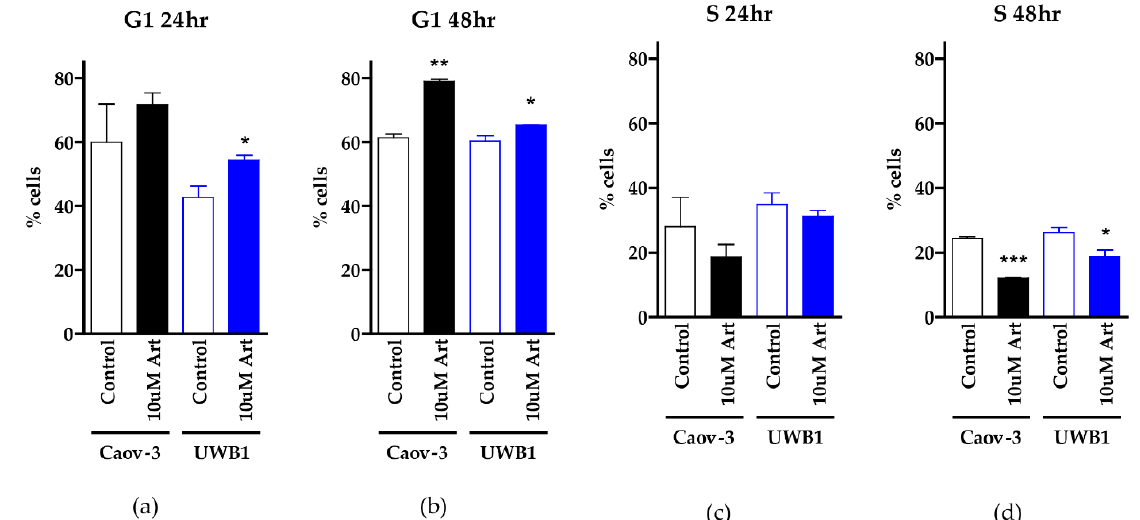
Figure 4. Cell cycle analysis using propidium iodide staining. The percentage of Caov-3 and UWB1 cells in G1 after 24 h ( a ) or 48 h ( b ) treatment with 0.1% DMSO (control) or 10 μM artesunate is graphed as the mean +/− SD from three independent experiments. A one-tailed unpaired t-test revealed a statistically significant increase in cells in G1 in UWB1 cells treated for either 24 or 48 h (* p < 0.05) and in Caov-3 cells treated with artesunate for 48 h (** p < 0.01). The concurrent analysis of the percentage of cells in S phase following 24 ( c ) or 48 ( d ) hour treatment with artesunate reveals a significant decrease in cells in S phase after 48 h (* p < 0.05; *** p < 0.001).